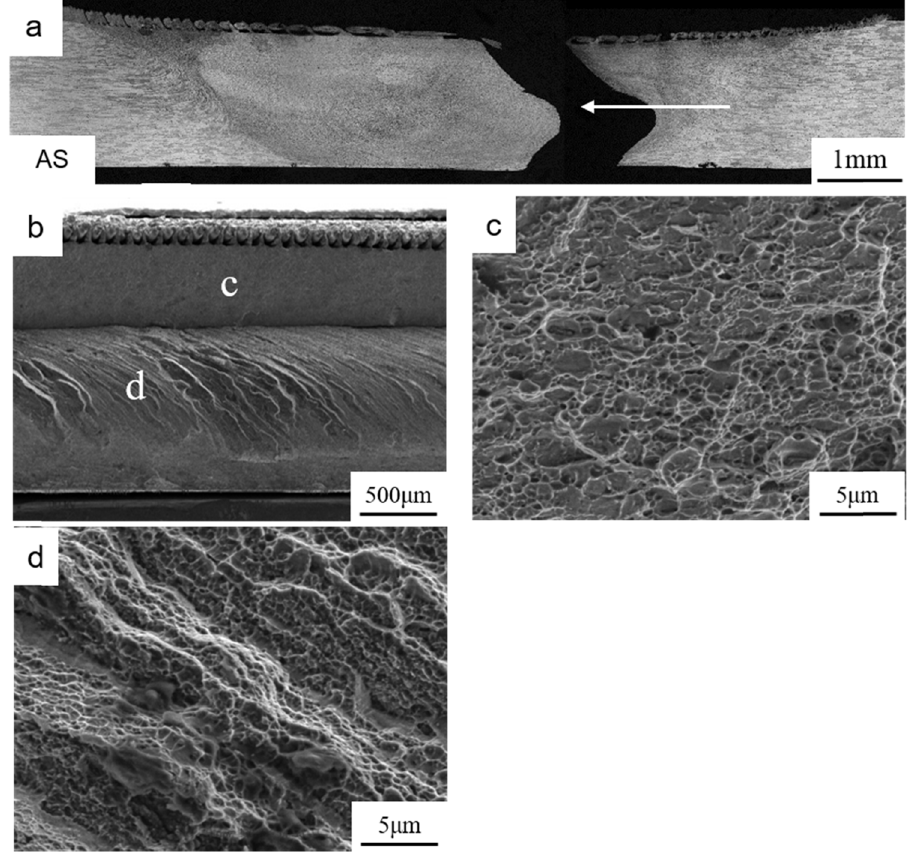
Figure 11: ( a ) OM of as - tested B1 specimen and observation direction of SEM indicated by white arrow; SEM of ( b ) fracture surface and ( c ) and ( d ) local zones in ( b )